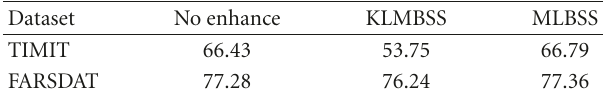
Table 2: Phoneme recognition accuracy rate (%) in clean environ-